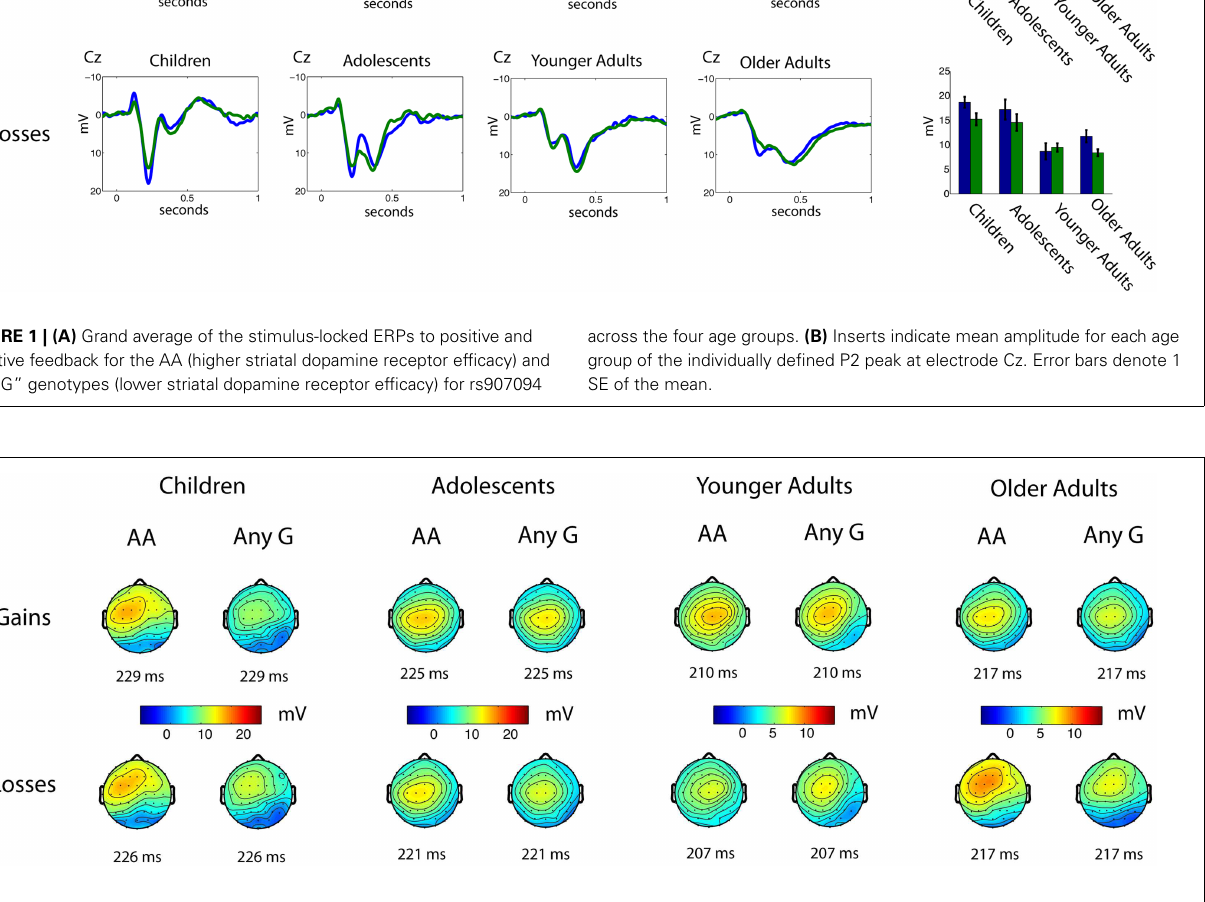
groups. Timings below the maps are given relative to stimulus onset. Maps are based on mean amplitudes of a 50ms interval around indicated time. Please note the different scale for children and